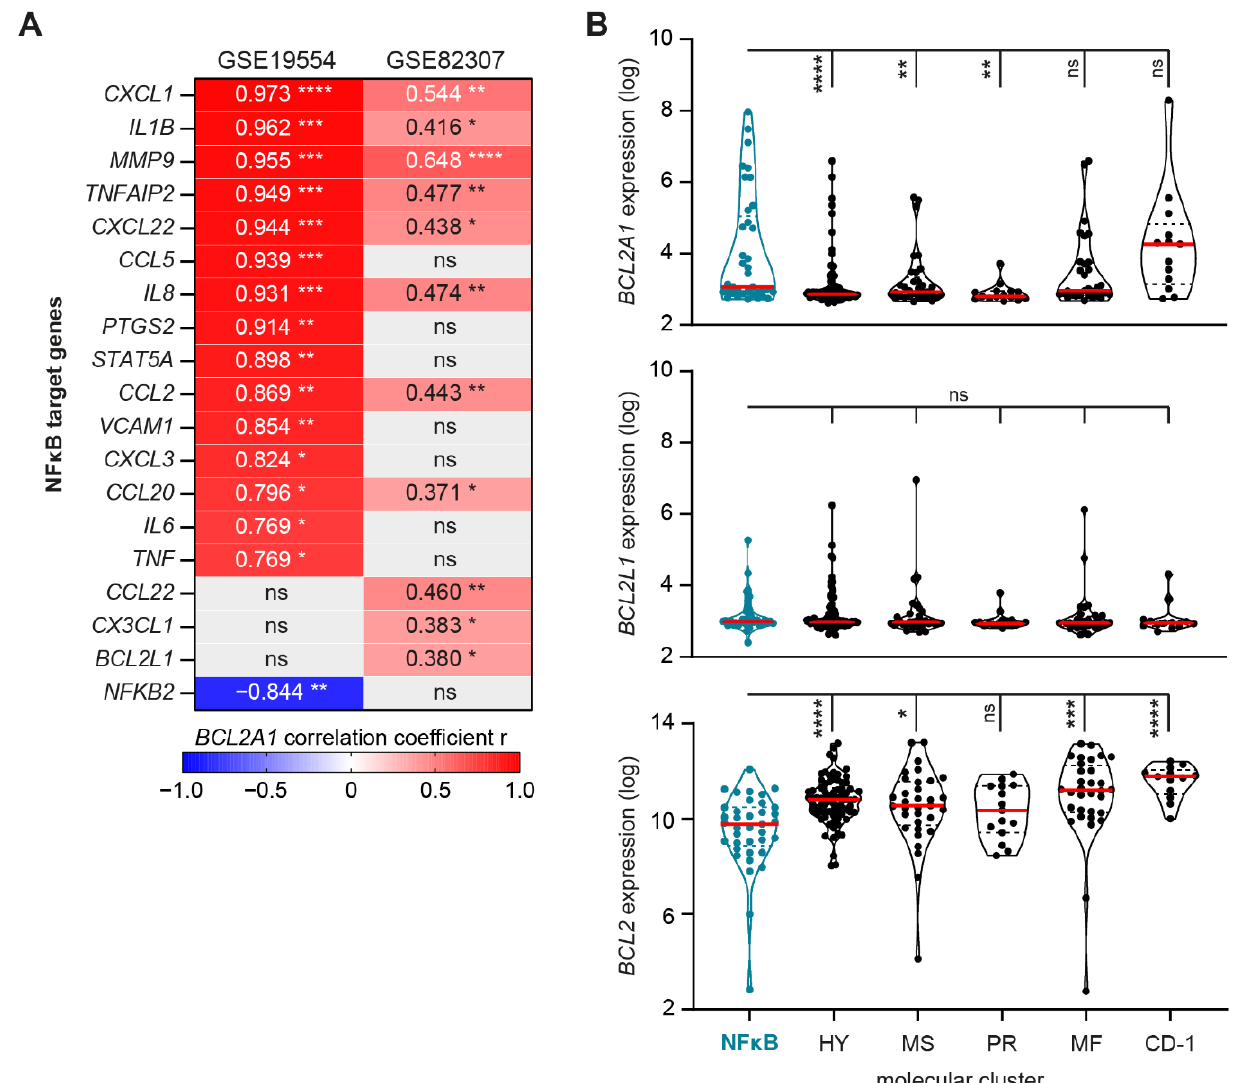
Figure 4. ( A ) Heatmap showing correlation coefficient (R value) between differential BCL2A1 expression and differential expression of NF κ B target genes included in the STA analysis, as determined by mRNA transcript expression in PC from MM patients at diagnosis versus mRNA transcript expression after relapse to first-line total therapy, with (dataset GSE19554) or without (GSE82307) subsequent administration of second-line induction therapy. ( B ) Violin plots showing BCL2A1 , BCL2L1 , and BCL2 mRNA transcript expression in PC of newly diagnosed MM patients, as incorporated in dataset GSE19784, in molecular cluster NF κ B, and in molecular clusters HY, MS, PR, MF, and CD-1 that all showed a significant lower STA NF κ B activity score compared to molecular cluster NF κ B in Figure 1C. Included samples are represented by individual data points, solid red lines indicate the median, and dashed lines indicate the quartiles of the population. ns, not significant, * p < 0.05, ** p < 0.01, *** p < 0.001, **** p < 0.0001.